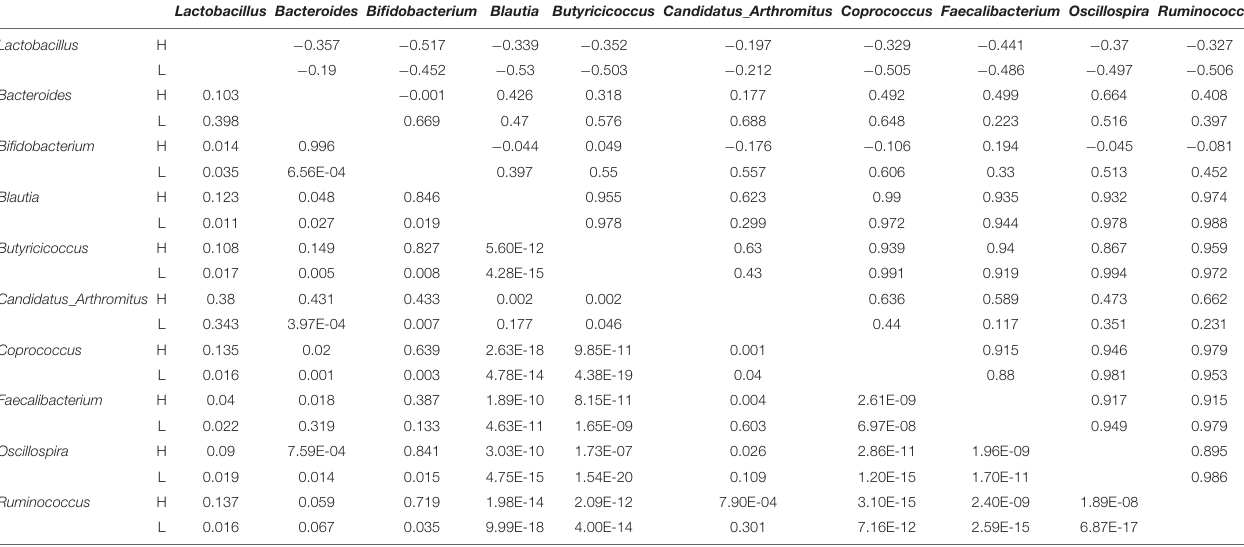
TABLE 3 | Correlation coefficient and significance of part of the microbes at genus level in the ileum of HFE and LFE groups. Lactobacillus Bacteroides Bifidobacterium Blautia Butyricicoccus Candidatus_Arthromitus Coprococcus Faecalibacterium Oscillospira Ruminococcus